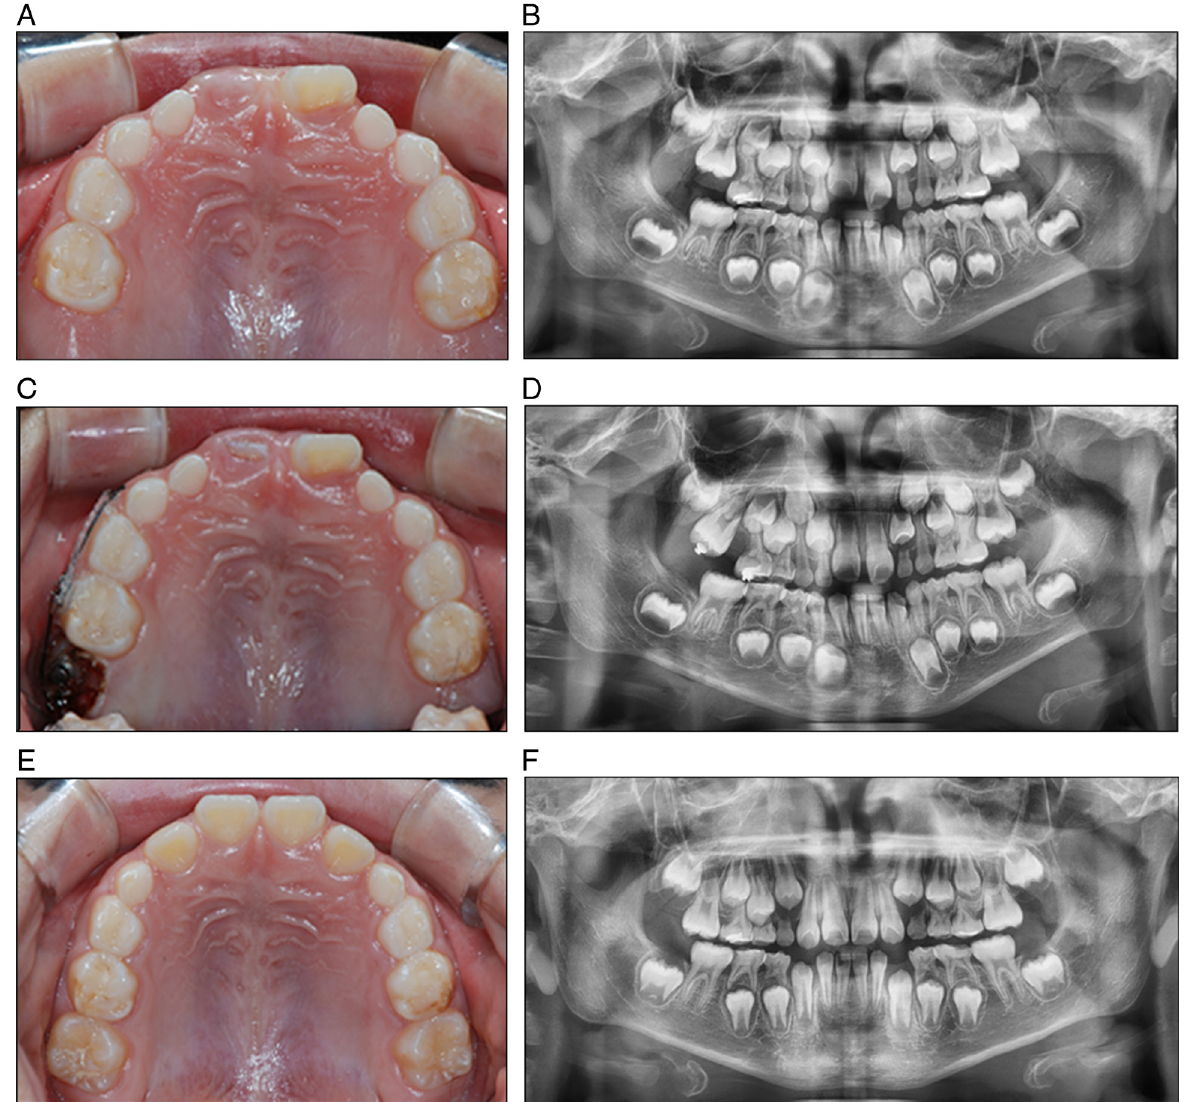
Figure 2. Case 1. A and B, Pretreatment. C, Segmental wire application to distally upright the right first maxillary molar. D, Distal uprighting of the right first molar was fully achieved two months after treatment began. E and F, 24 months after